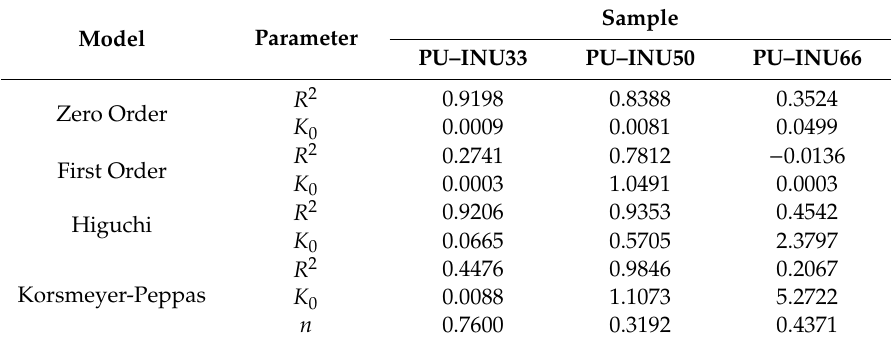
Table 5. Mathematical model correlates coe ffi cients and release exponents for PU–INU. Model